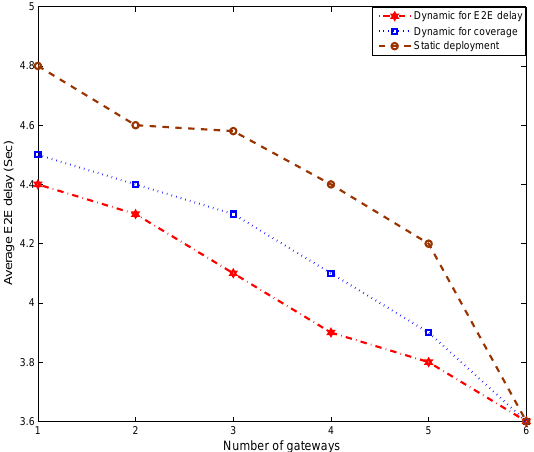
Figure 10. Minimization of average end-to-end